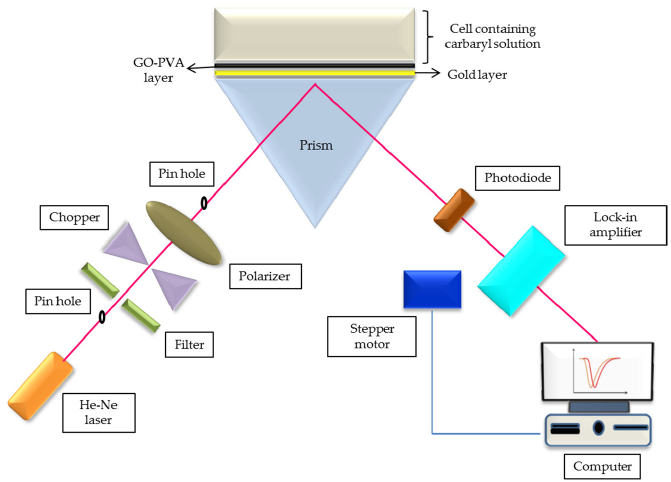
Figure 2. Set-up of surface plasmon resonance (SPR) instrument for sensing performance of the graphene oxide- polyvinyl alcohol (GO-PVA) thin